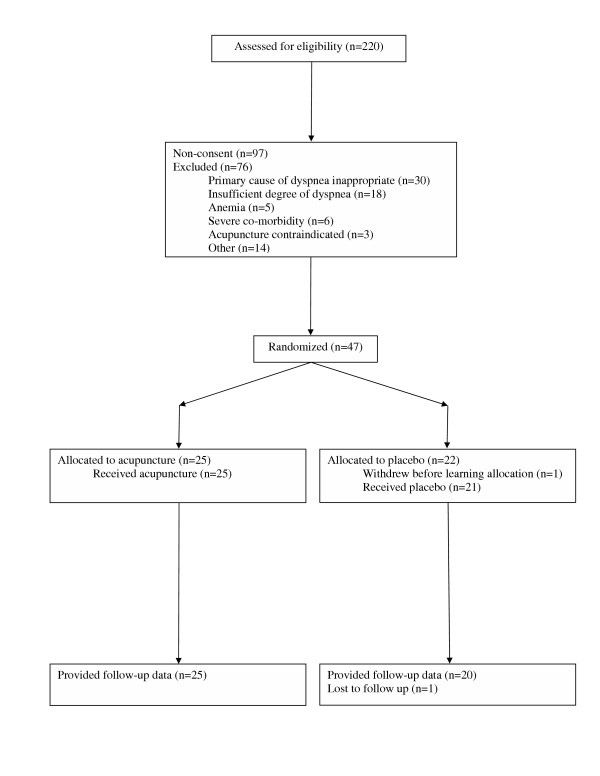
Flow of participants through the trial.